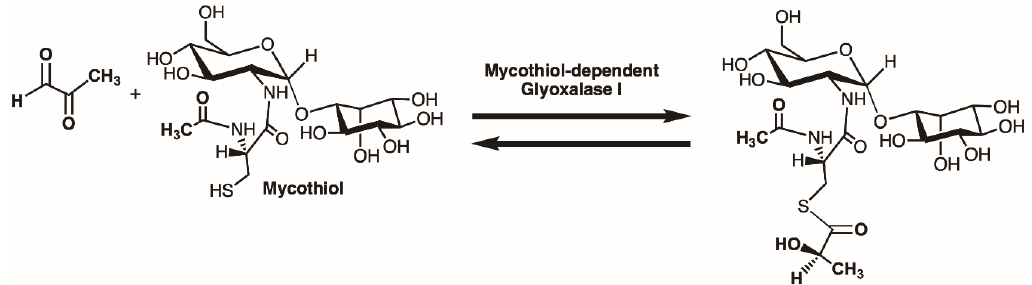
Figure 4. The overall reaction of a mycothiol-dependent glyoxalase I enzyme.